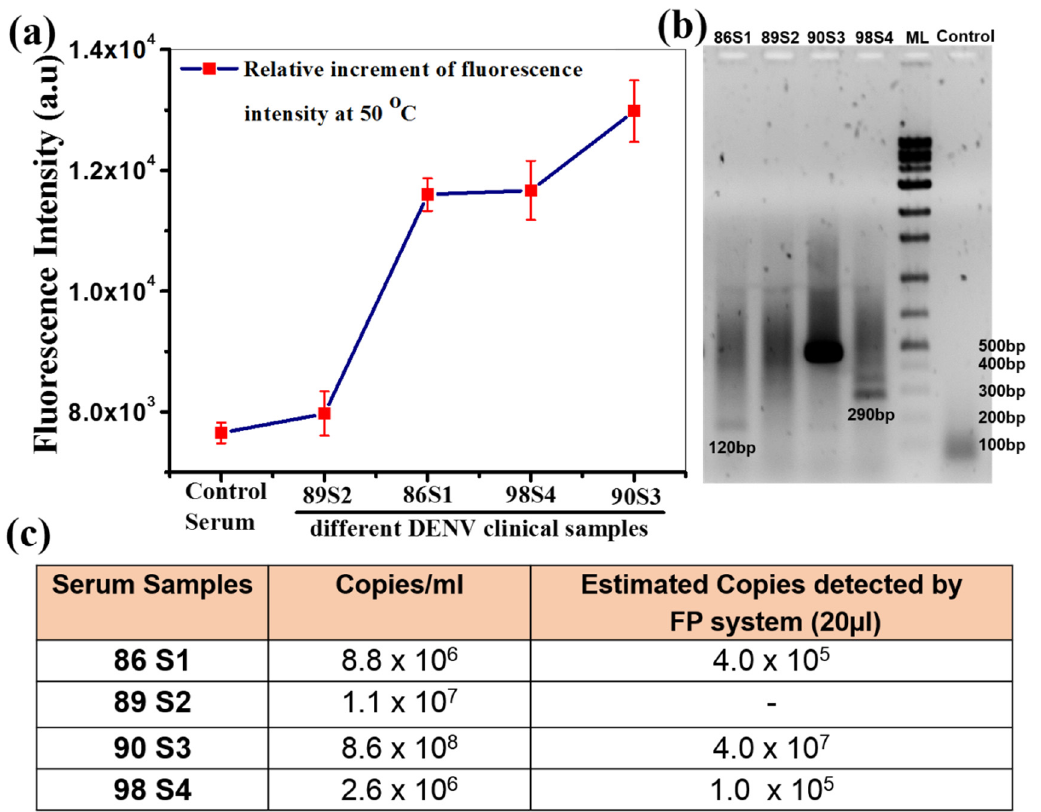
Figure 3. ( a – c ) Detection of clinical DENV serum samples. ( a ) Relative increment of fluorescence intensity of various clinical samples, measured with Mg-PDTG probe. ( b ) Agarose gel (1%) electrophoresis image of the qRT-PCR products, obtained from viral RNA isolated from different clinical DENV samples. ( c ) Analysis of qRT-PCR data to measure the DENV copies/mL in different clinical samples. FP system: fluorescence probe system. Each experiment was performed thrice ( n = 3), and error bars represent the standard deviation of fluorescence intensity measurement from the average value.